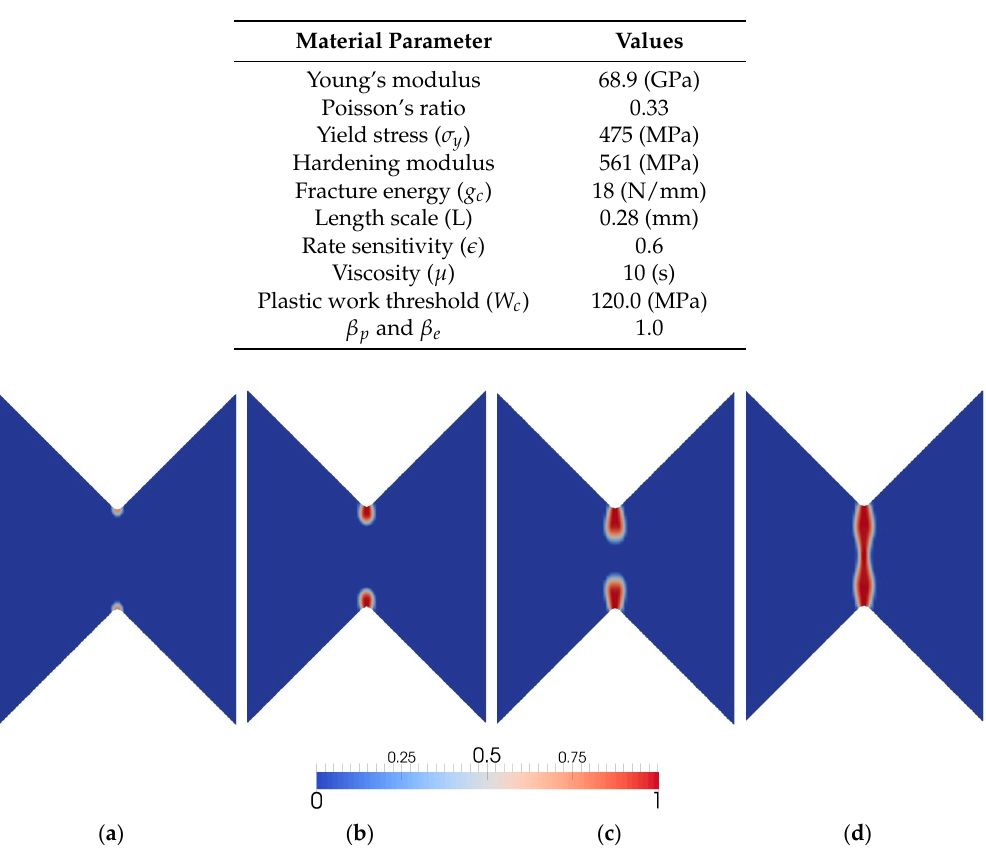
Figure 3. The V-notched plane strain tension test: ( a ) the geometry and associated dimensions (in mm) and ( b ) the finite element discretization. Table 2. Model parameters for the V ‐ notched sample of Al ‐ alloy 6061 material. Table 2. Model parameters for the V-notched sample of Al-alloy 6061 material.